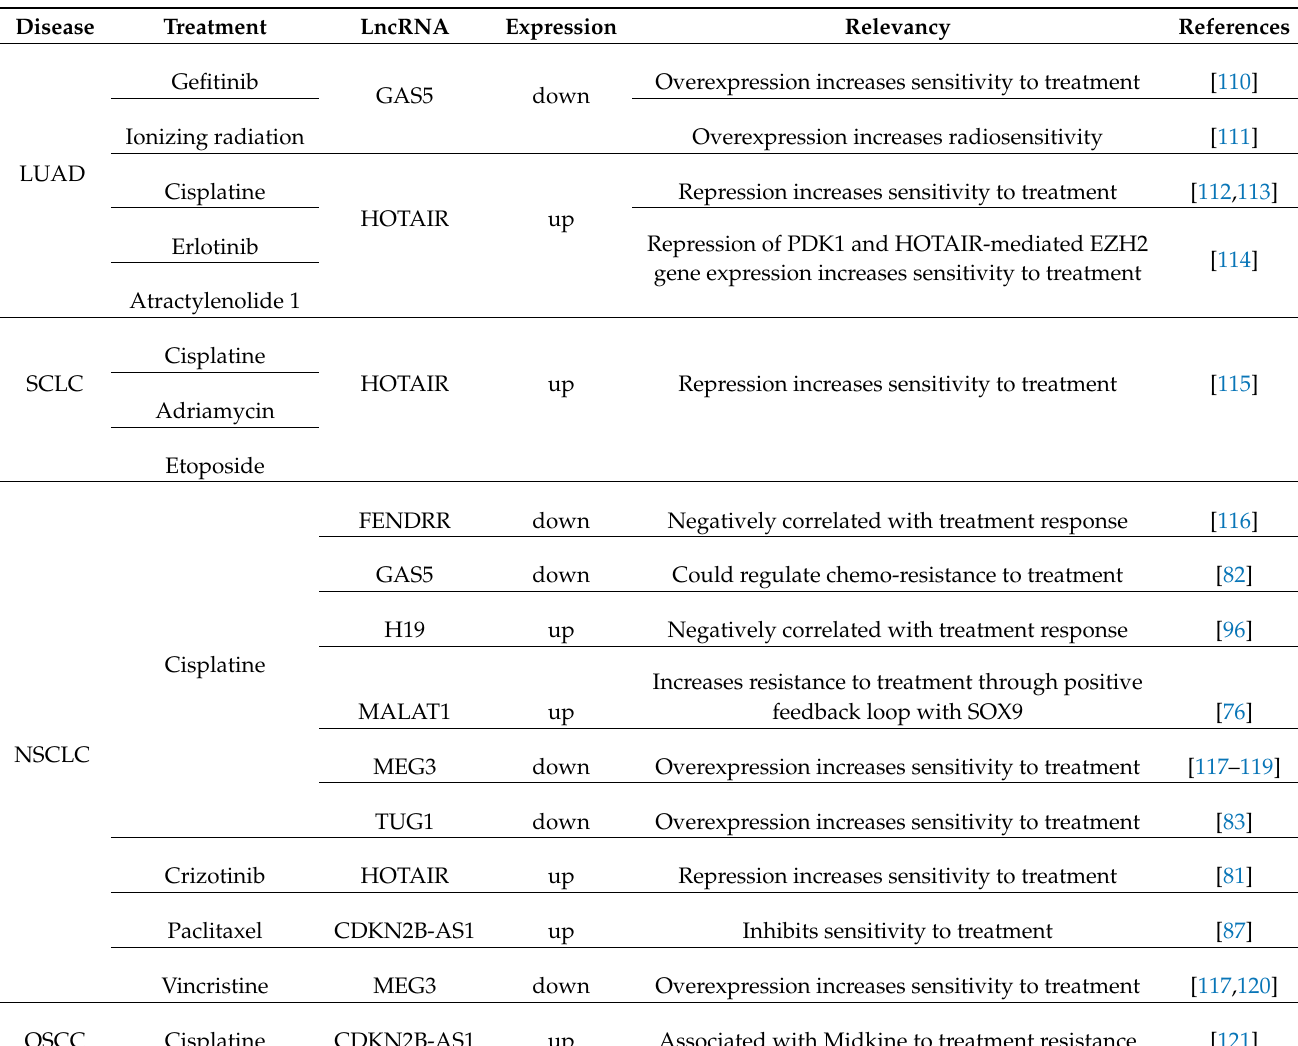
Table 3. Lung cancer treatment resistances associated to the eight lncRNAs described in lung